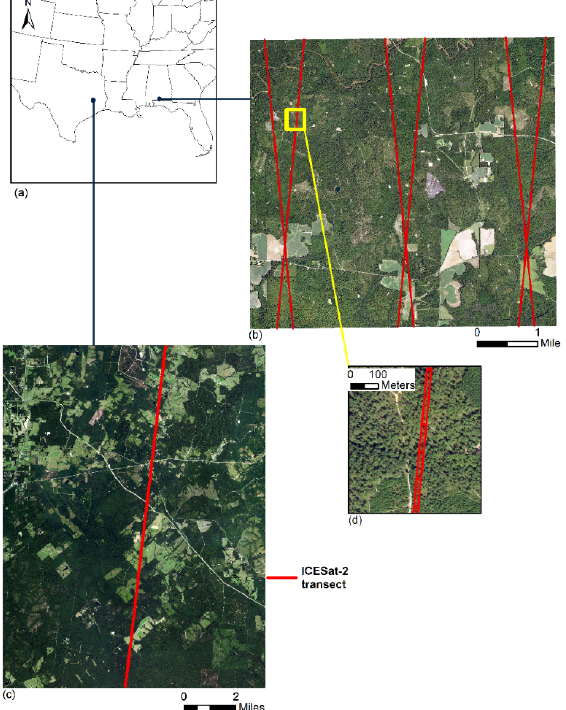
Figure 2. ( a ) Location of study sites within the Southern US, ( b ) ICESat-2 tracks (only strong beams) over the Solon Dixon Forestry Education Center in southern Alabama, ( c ) ICESat-2 tracks over the Sam Houston National Forest (SHNF) site in south-east Texas, and ( d ) Visual representation of a sample of ATL08 segments over SDFEC. Data are overlaid on 1 m National Agriculture Imagery Program (NAIP)